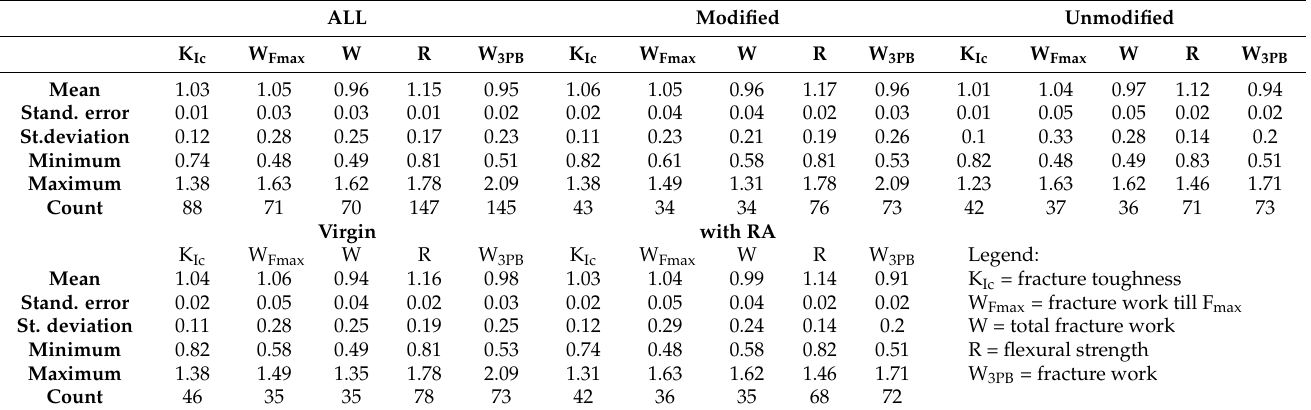
Table 1. Aging index and related basic